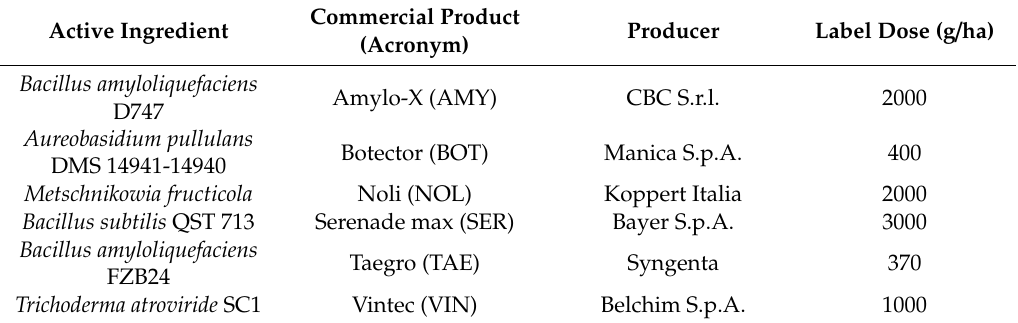
Table 1. Biocontrol agents (BCAs) used in the experiment.